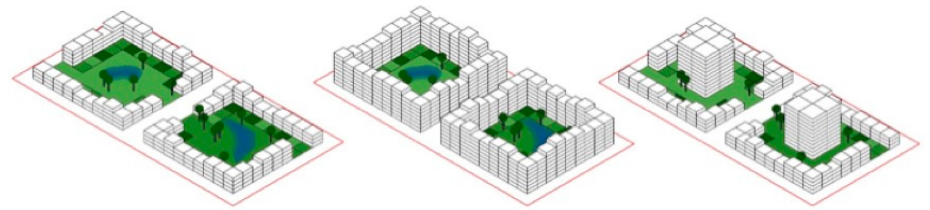
Figure 5 . Different court building types have different influence on biodiversity and ecosystem services (BES). To what extent and in what ways represent a future research frontier in SEU.